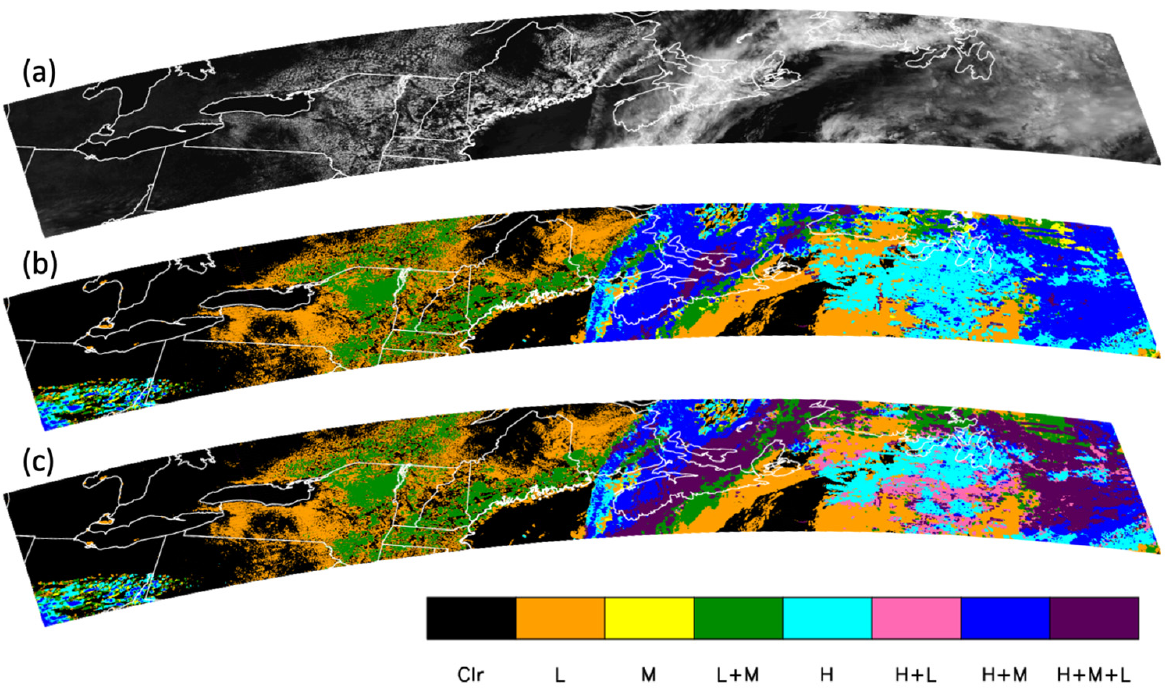
Figure 10. Example CCL product for NOAA-20 VIIRS at 1718 UTC on 28 June 2022. ( a ) Channel M5 (0.672 µ m) reflectance, ( b ) CCL product without machine learning model, and ( c ) CCL product with machine learning model applied. Colorbar refers to cloud layer categories in ( b , c ).